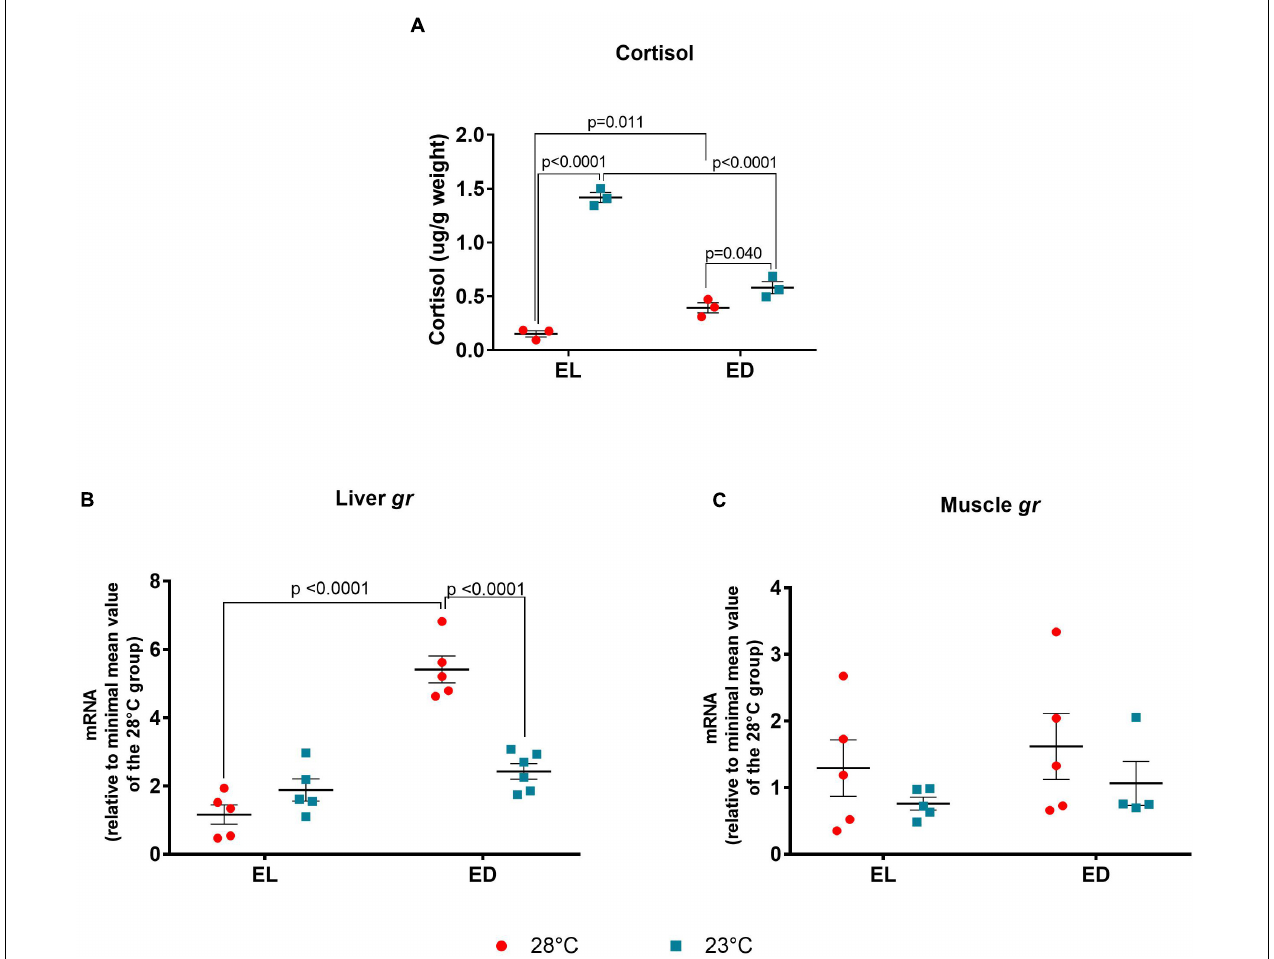
FIGURE 4 | Early light (EL) and early dark (ED) whole body cortisol and gene expression of glucocorticoid receptor ( gr ) in adult Danio rerio . (A) Cortisol levels; (B) liver gr ; (C) muscle gr . The hormone concentration ( µ g) was normalized by sample weight (g, Supplementary Table S2 ). The gene expression was normalized by the 18S rRNA and expressed relative to the lowest mean of the control temperature group. The values are expressed as mean ± SEM. n = 3 (pools of four animals each). Significant differences are shown when p < 0.05. Red symbol corresponds to 28 o C and blue symbol corresponds to 23 o